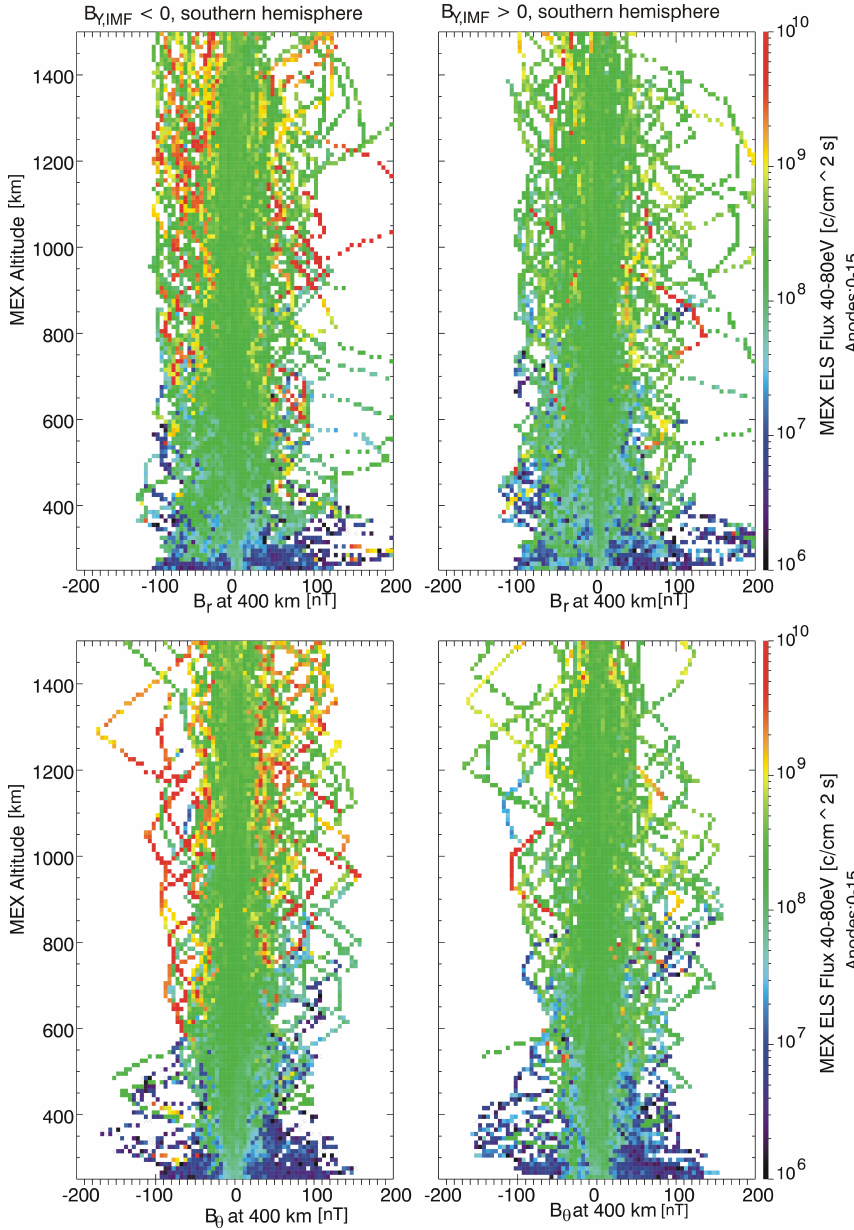
Fig. 7. Total median flux of electrons (40ev <E e < 80eV) on the nightside of the Southern Hemisphere as a function of the vertical ( B r ) and horizontal ( B θ ) and altitude for B y IMF > 0 and B y IMF <